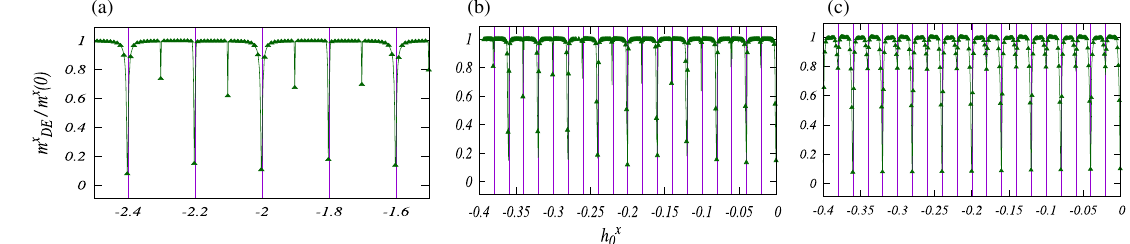
=m x h x 0 versus 0 . The observable, initial states at zero DE